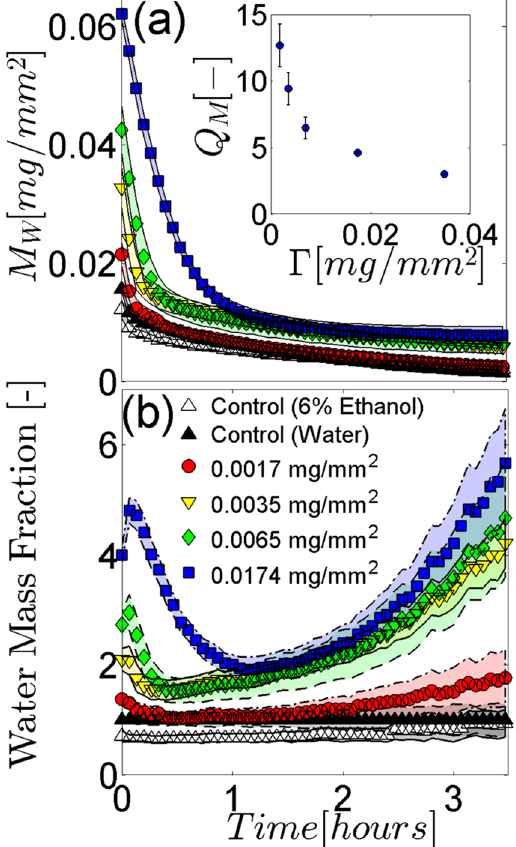
Figure 7. Evaporation kinetics of DNA film coated SC. ( a ) Average area scaled water mass, M W , of control and DNA film coated SC samples drying over time in a 24% R.H. environment. Control results include SC samples coated with DIW water (black triangle) and 6% aqueous ethanol solutions (white triangle). DNA film coating results include surface densities of 0.00173 (red circle), 0.00347 (yellow inverted triangle), 0.00694 (green diamond), and 0.0174 mg/mm 2 (blue square). Shaded regions denote standard deviations of n = 3 individual SC samples. (Inset) Average mass swelling ratio, Q m , plotted against DNA film surface density, Γ . Error bars denote standard deviations of n = 3 individual SC samples. When not visible, errors are smaller than the symbol size. ( b ) Results from panel ( a ) scaled by the DIW coated control results (black diamond). Shaded regions denote propagated standard